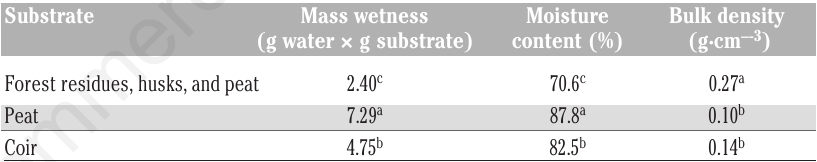
Table 2. Mass wetness, moisture content, and bulk density of three commercial sub- strates.